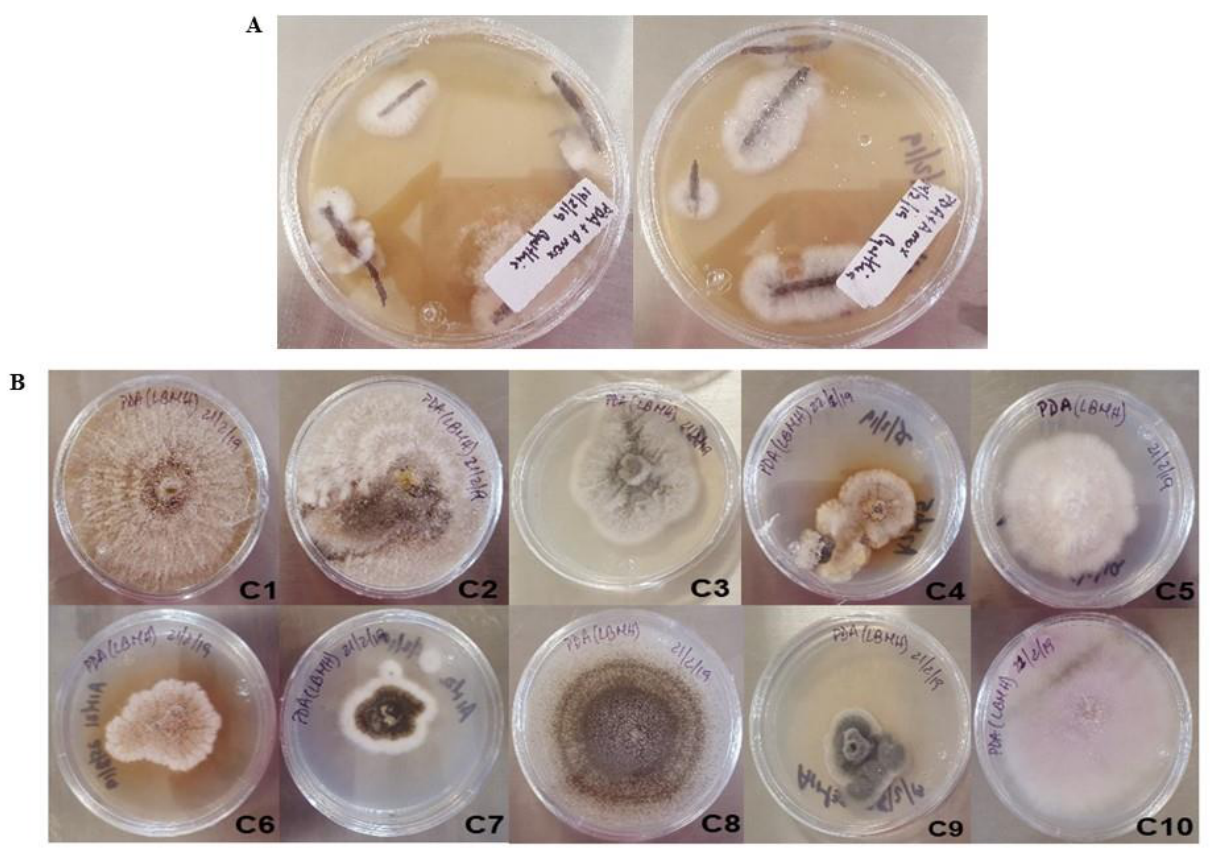
Figure 1. Fungal isolates from Prosopis laevigata roots from a mine tailing. ( A ) Mycelia emerging from the disinfected roots. ( B ) Isolated morphotypes after visual screening.